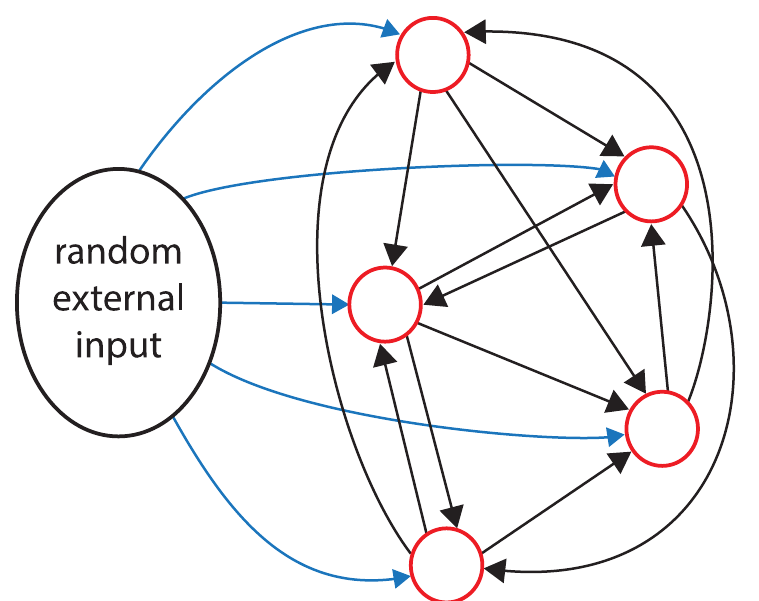
Fig 5. Single cell-type excitatory network. In this network model, identical model neurons are randomly connected, with a chance of connection from one neuron to another defined by esyn 1 . Connection can independently go in both directions. Network synaptic transmission is modelled by a single spike generating a single EPSP in connected neurons, subject to random transmission failure (0.5 chance), and fixed random transmission delay within a defined range, usually 5–15 ms. Neurons also receive randomly timed external synaptic input at a defined rate, of mixed EPSPs and IPSPs.